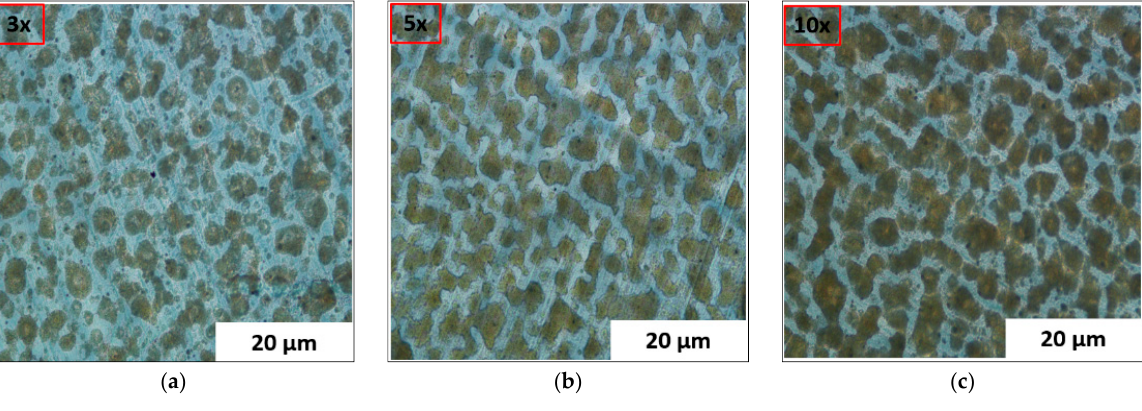
Figure 3. ( a ) OM image of 3× ZnO NP-coated poly(3-hydroxybutyrate- co -3-hydroxyhexanoate) (PHBHHx) substrate; ( b ) OM image of 5× ZnO NP-coated PHBHHx substrate; ( c ) OM image of 10× ZnO NP-coated PHBHHx substrate.